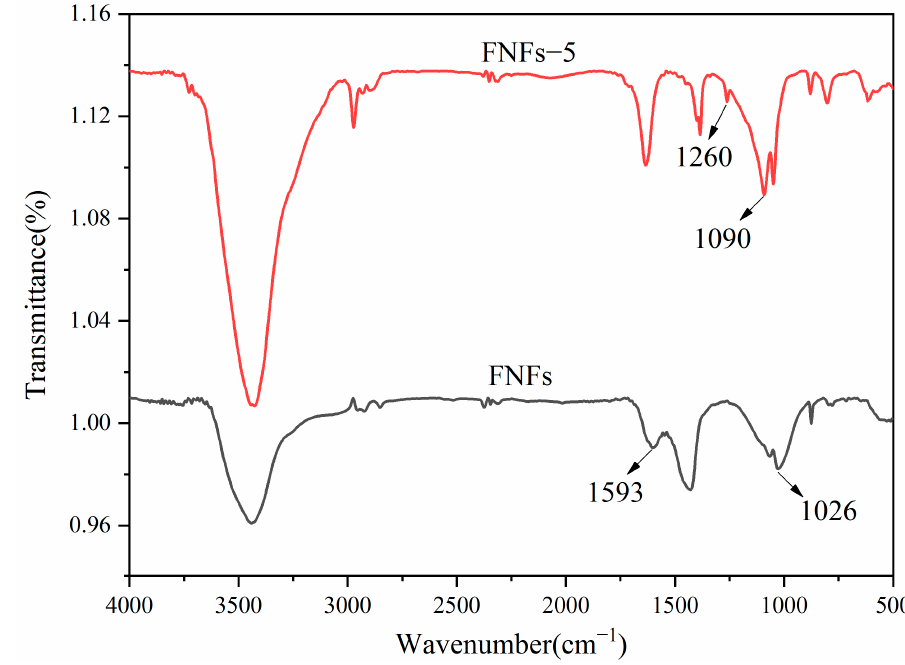
Figure 10. FTIR of FNFs and FNFs-5 after combustion.